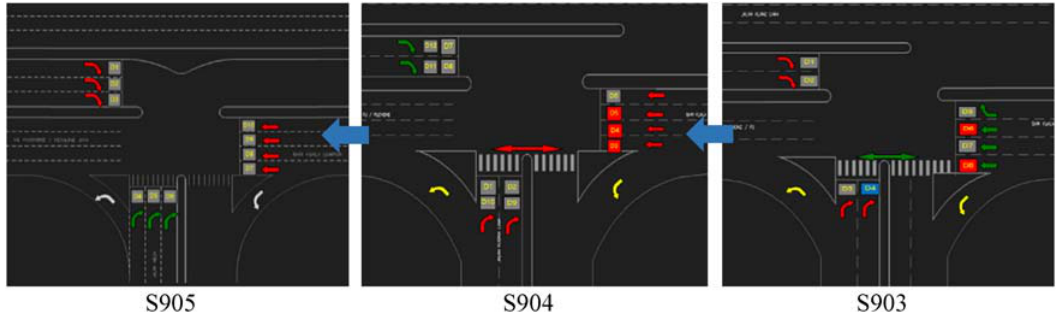
Figure 4: Heavy fl ow direction from S903 to S905 ( right to the left ) .